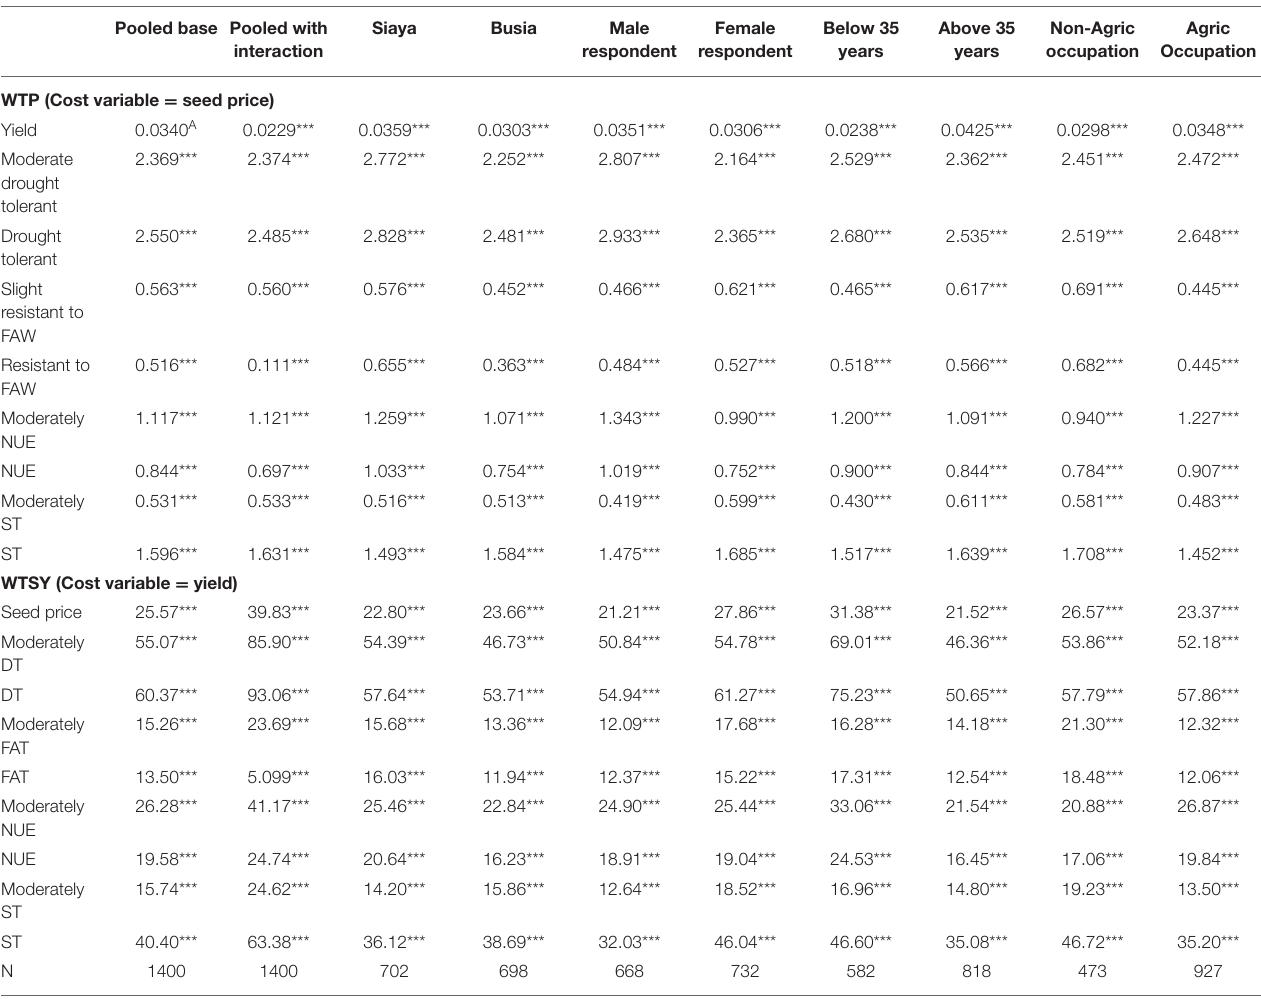
TABLE 3 | Mean willingness to pay (WTP) and willingness to sacrifice (WTSY) for maize variety attributes, by location and demographics. Pooled base Pooled with